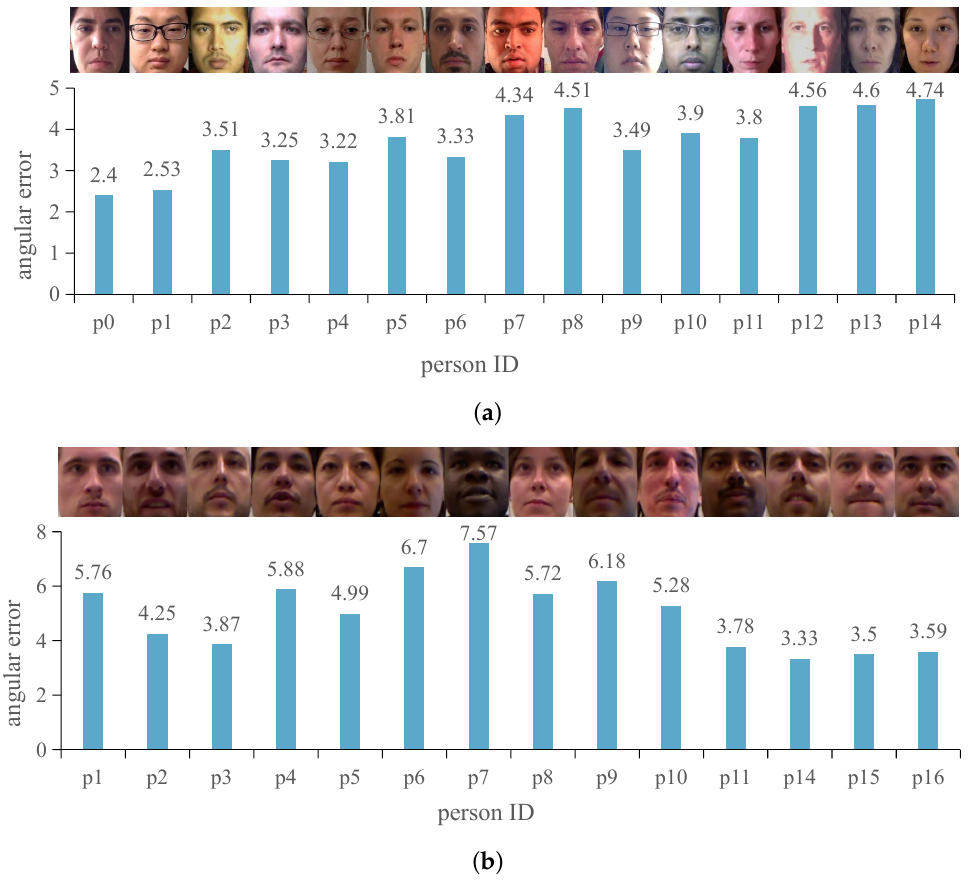
Figure 9. The angular error of the STTDN among the different experiment participants: ( a ) records the angular error of the different experiment participants (p0–p14) on the MPIIFaceGaze dataset [20]; ( b ) records the angular error of the different experiment participants (p1–p16) on the Eyediap dataset [42]. The angular error is recorded on the vertical axis. Each experiment participant ID and its corresponding face image is recorded on the horizontal